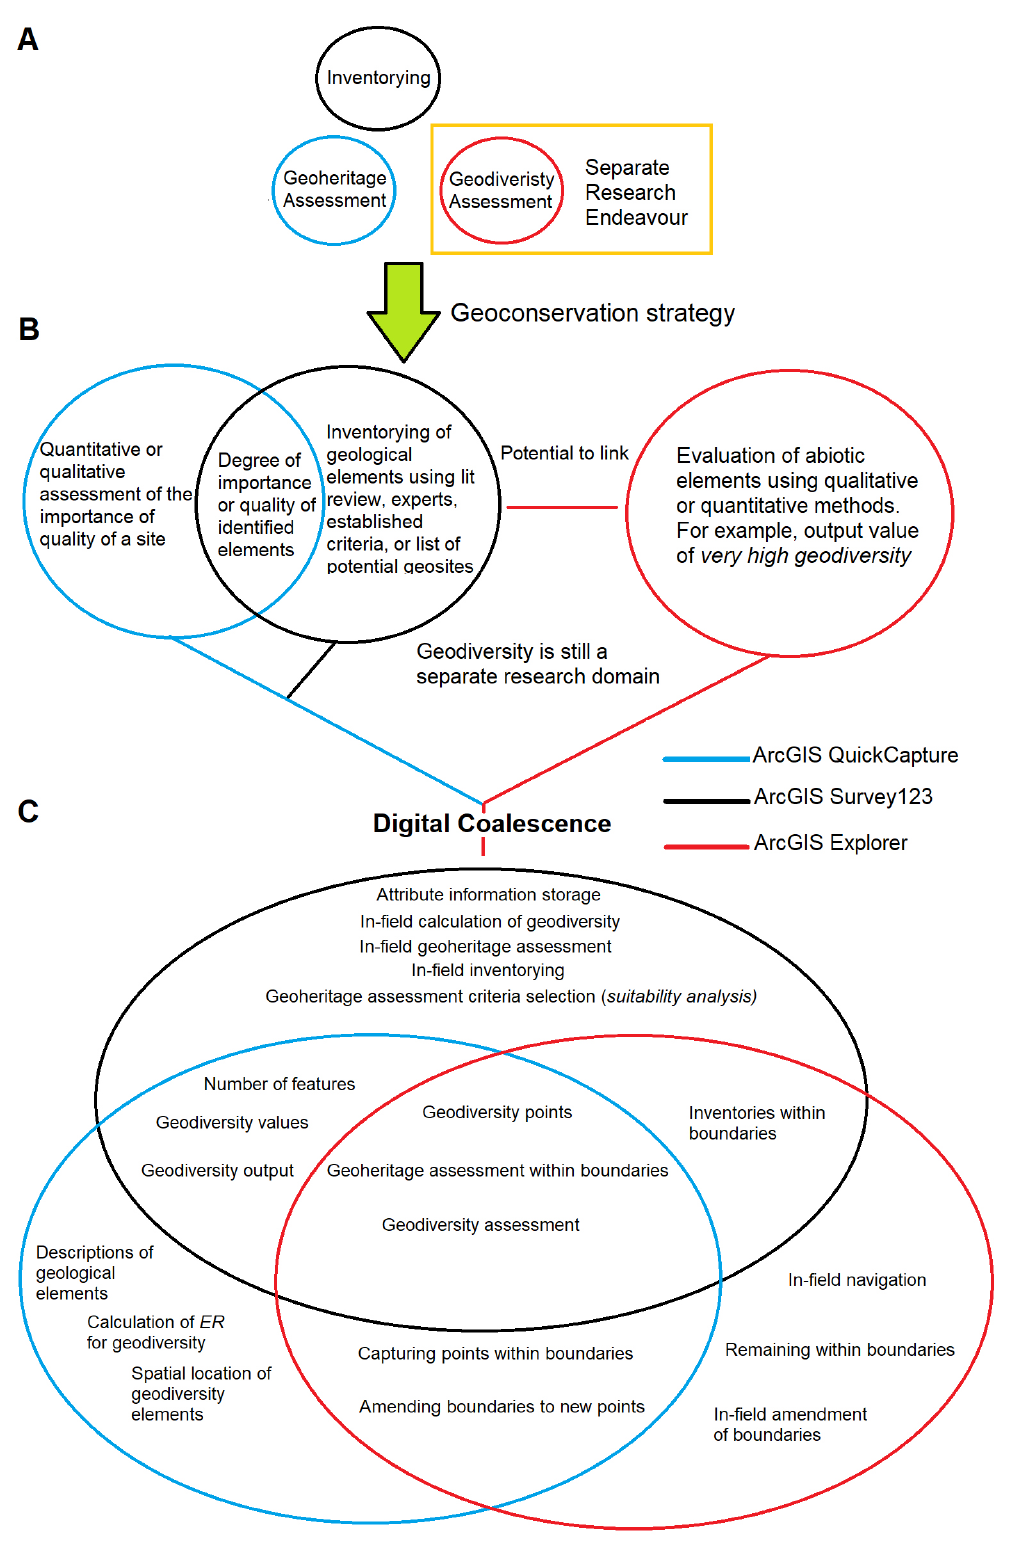
Figure 5. A conceptual model indicating how the digital coalescence of three ArcGIS mobile apps consolidates quantitative geodiversity assessment with geoconservation strategies. A) Geodiversity and geoheritage assess- ment and inventorying are distinctively separate steps. B) Inventorying and geoheritage assessment in the geoconservation strategy are currently separate research endeavors from quantitative geodiversity